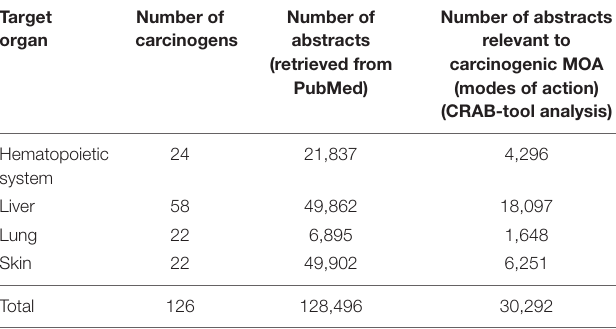
TABLE 1 | Literature data for carcinogens affecting the hematopoietic system, liver, lung, and skin in National Toxicology Program’s (NTP) 2-year rat